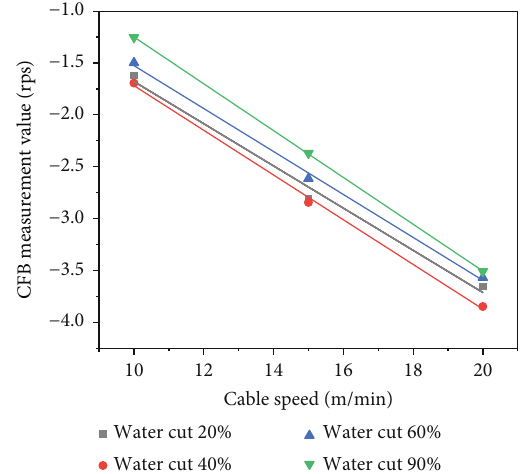
Figure 15: Relational graph of the measured value of 85 ° inclination of 600 m 3 /d CFB and cable